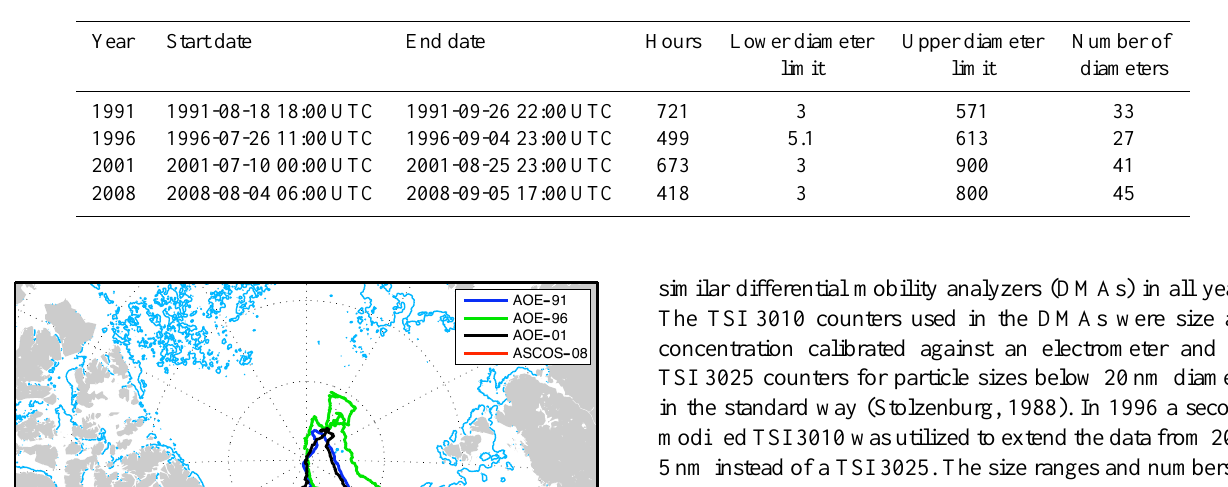
Table 1. Start and end dates of the aerosol data taken within the central pack ice in 1991, 1996, 2001, and 2008, number of hourly averages in ice, lower and upper diameters of the scanned size ranges in nanometers and the number of logarithmically evenly spaced diameters.